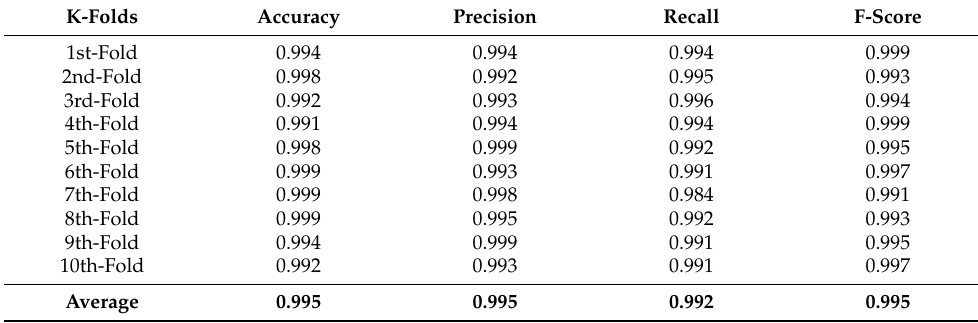
Table 8. Significance of VC(ETC+CNN) with k-fold